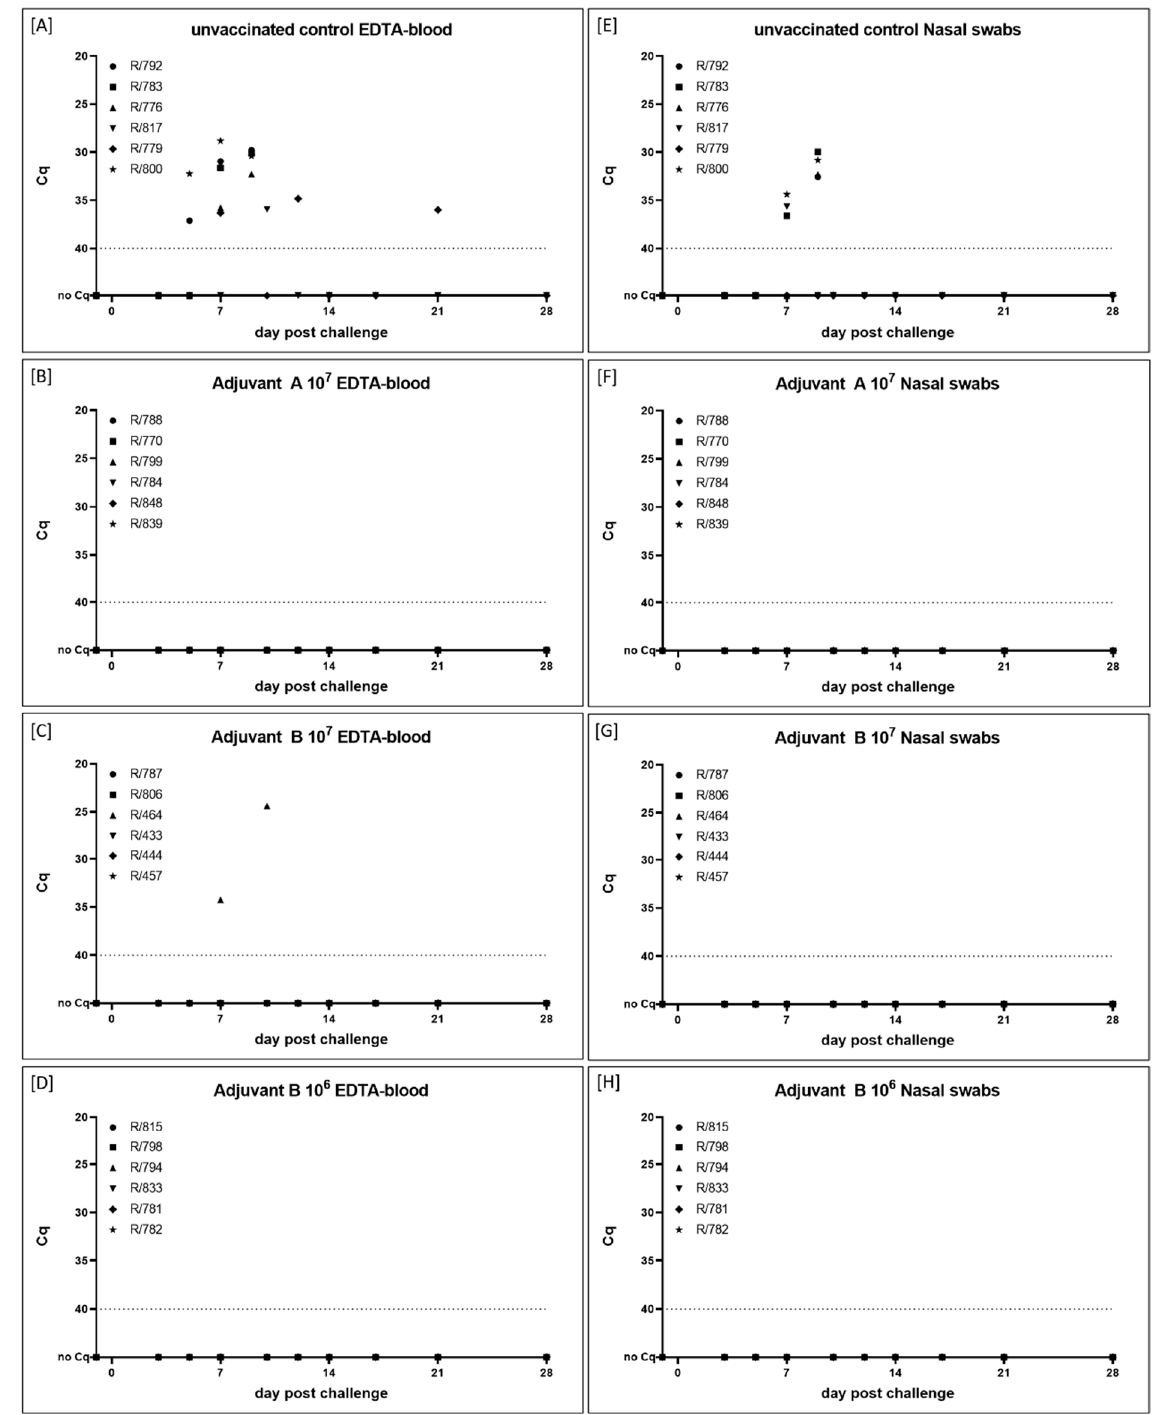
Figure 11. Viral genome load in ( A – D ) EDTA-blood and ( E – H ) nasal swabs taken during the vaccine-efficacy animal trial.